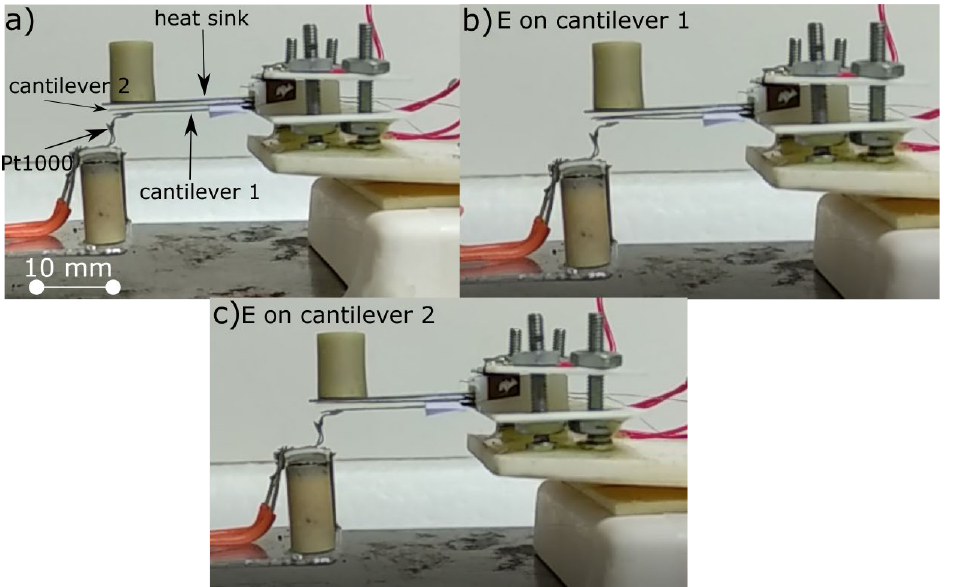
Figure 6. Snapshots of the proof - of - concept device. ( a ) Initial state of the cantilevers when no elec- tric field is applied. Cantilever 1 is in contact with the Pt1000, which acts as a heat source and as a temperature sensor at the same time. The upmost cantilever is the heat sink. The cylinder on the top of this cantilever was used to damp the vibrations of the structure. ( b ) State when the electric field is applied to cantilever 1. As a consequence, cantilever 1 bends and makes a contact with can- tilever 2. ( c ) State when the electric field is applied to cantilever 2, which bends and makes contact with the heat sink (the uppermost inactive cantilever).